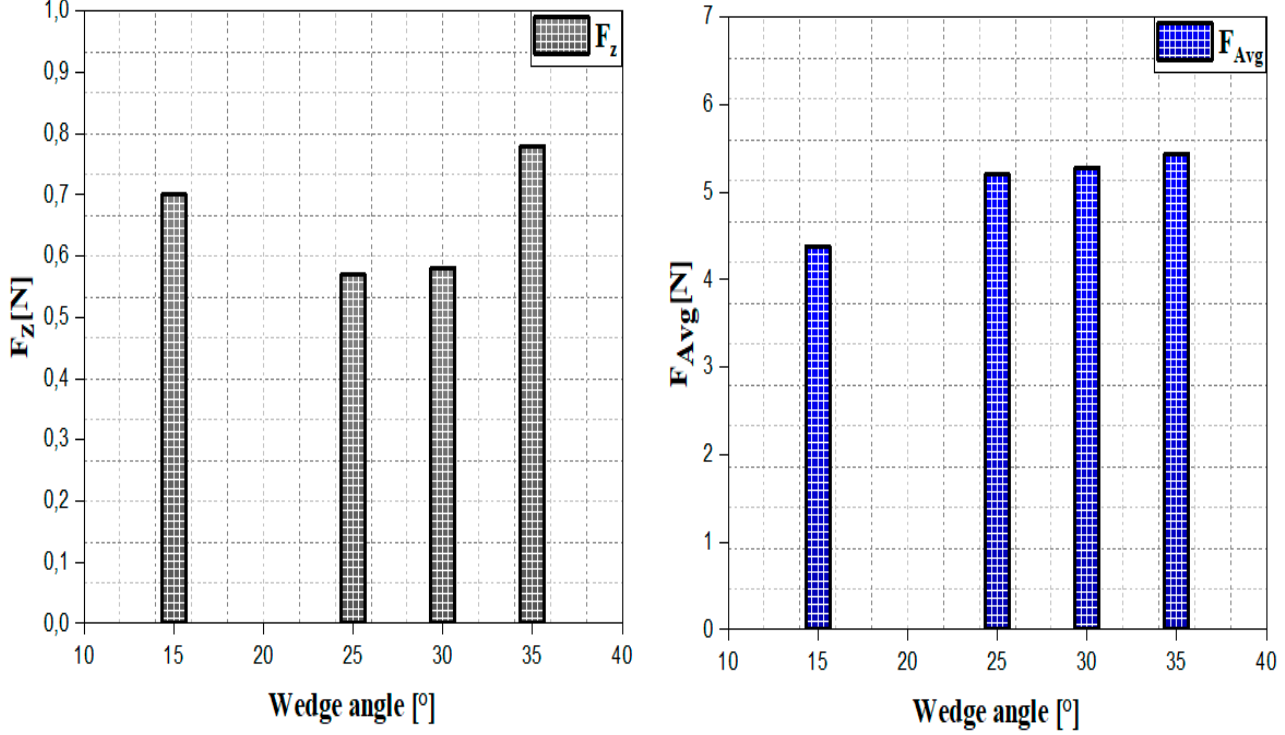
Figure 26. Evolution of F z and F Avg .